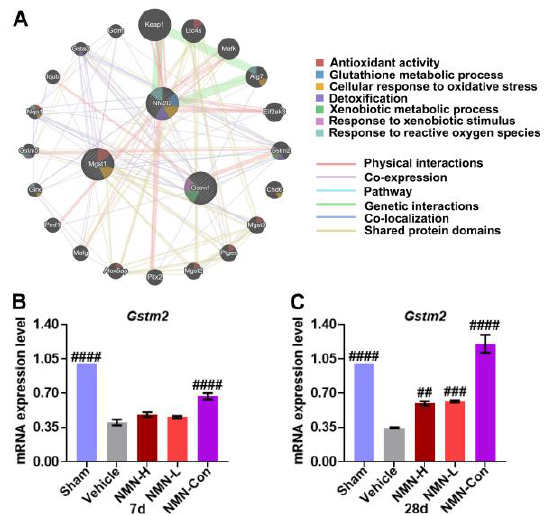
Figure 8. Gstm1 , Mgst1 , and Nfe2l2 gene interaction analysis and the expression of Gstm2 in silica-induced lung injury. ( A ) Gstm1 , Mgst1 , and Nfe2l2 gene–gene interaction network analysis from GeneMANIA database, Nfe2l2 interacts with Gstm1 and Mgst1 genes via Gstm2 ; ( B ) relative expression of Gstm2 mRNA in lung tissue at 7 d; ( C ) relative expression of Gstm2 mRNA in lung tissue at 28 d. ## indicates p < 0.01, ### p < 0.001, #### p < 0.0001 vs. Vehicle. Sham: saline + saline; Vehicle: silica + saline; NMN-H: silica + NMN (1000 mg/kg); NMN-L: silica + NMN (500 mg/kg); NMN-Con: saline + NMN (1000 mg/kg).